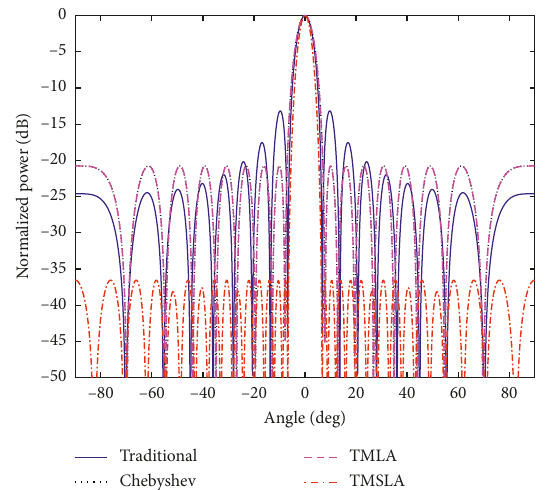
Figure 3: TMLA, TMSLA, Chebyshev, and traditional patterns.